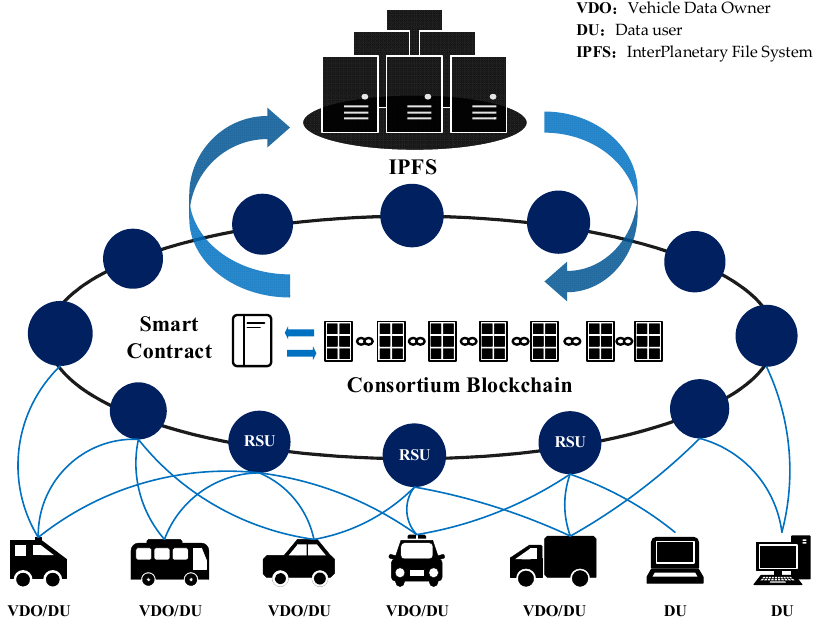
Figure 1. System Figure 1. System model.